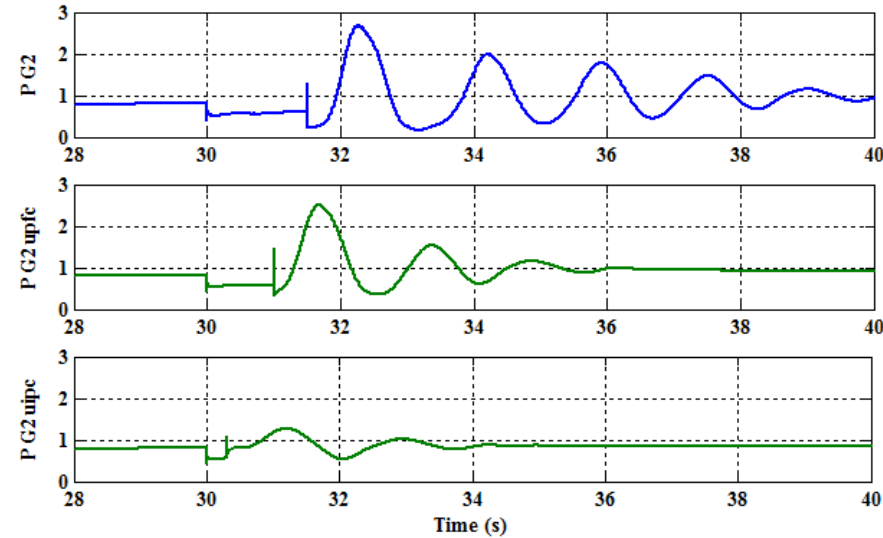
Figure 6. The output power of Generator 2 (left side G2) in three different modes: without any compensator, with UPFC, and with UIPC.